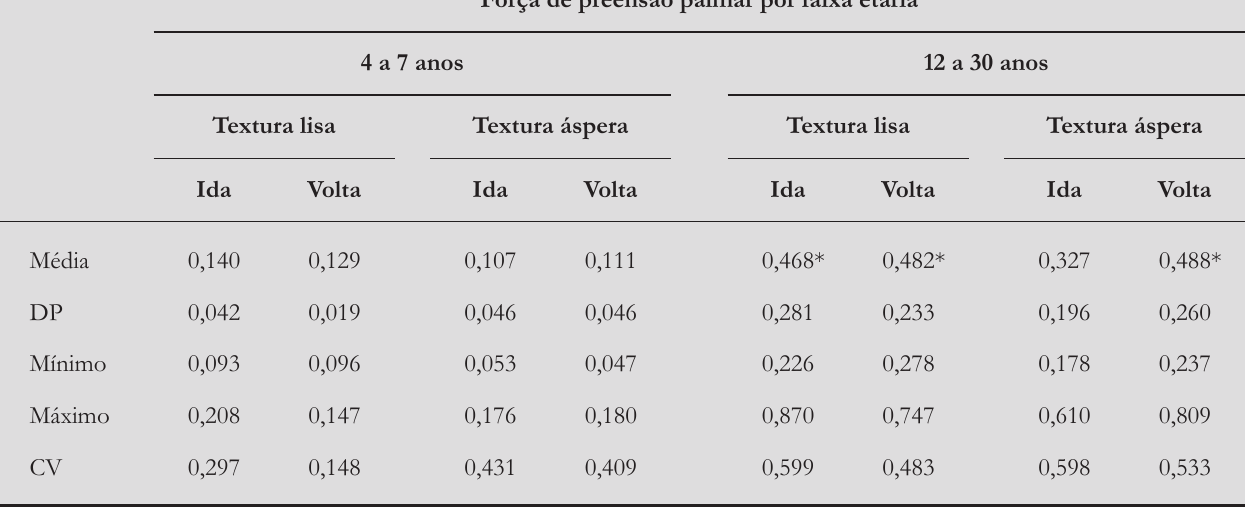
Tabela 3 - Resultados da análise da força de preensão palmar da mão dominante pela faixa etária durante os movimentos de ida e retorno (volta), para as diferentes